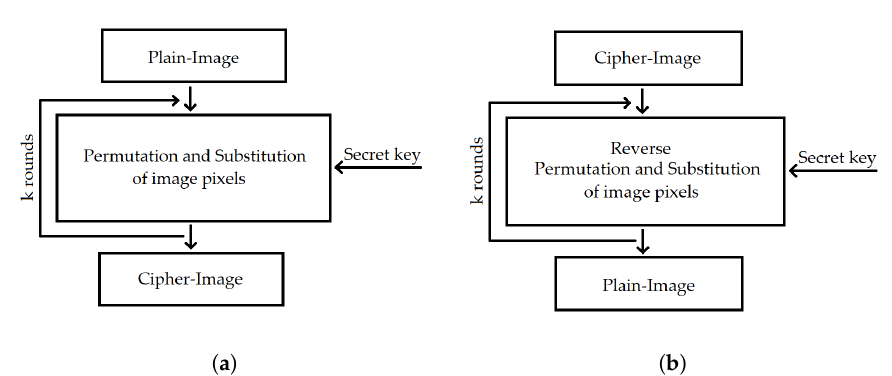
Figure 1. Encryption and decryption process of an image. ( a ) Image-encryption scheme. ( b ) Image decryption